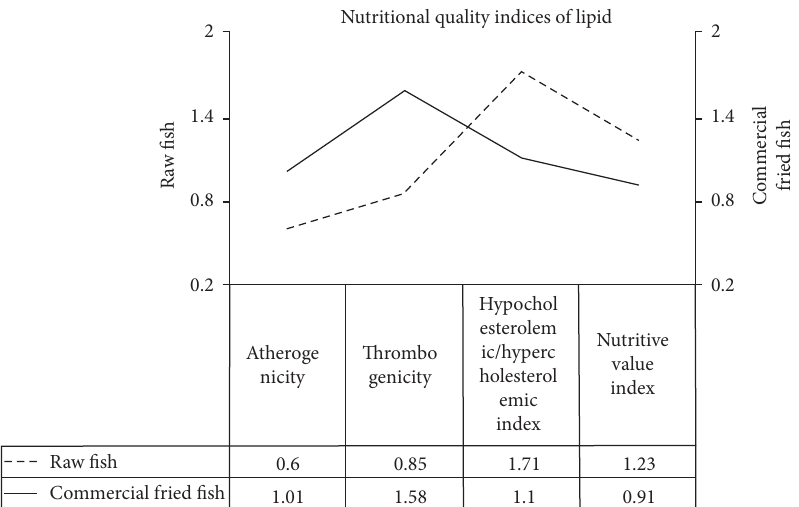
Figure 1: Nutritive value index of raw and commercial fried